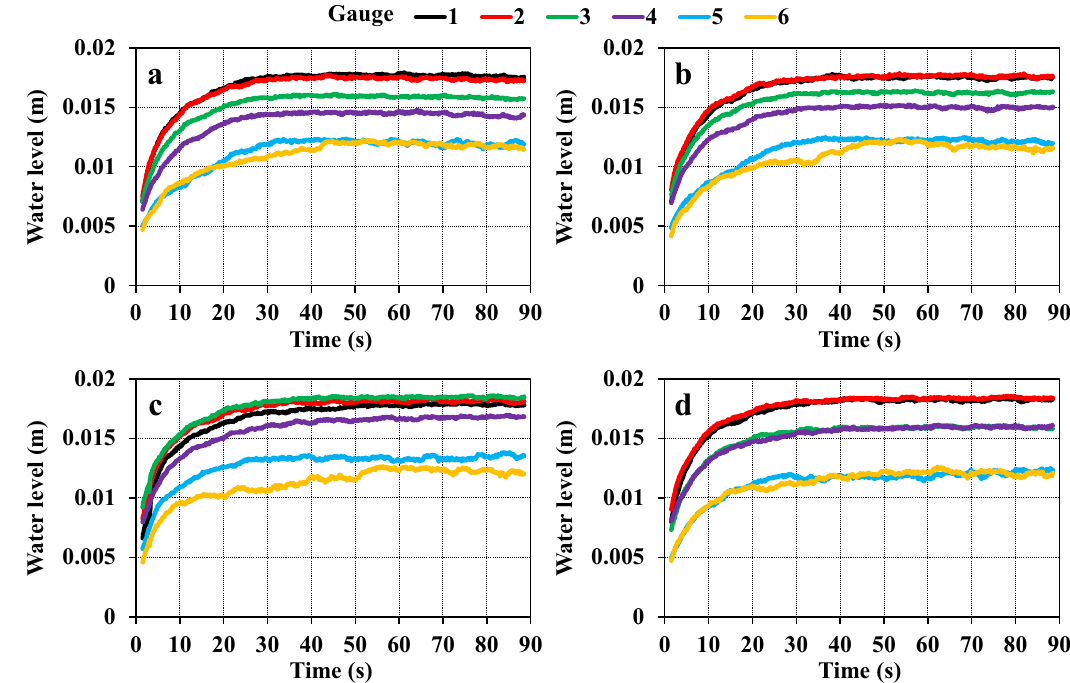
Figure 7. Temporal variations in water level. ( a ) current; ( b ) current (skewed); ( c ) old (spindle type); ( d ) old (current type). Water level datum: channel bed at gauge 4. Mean of five experiments.